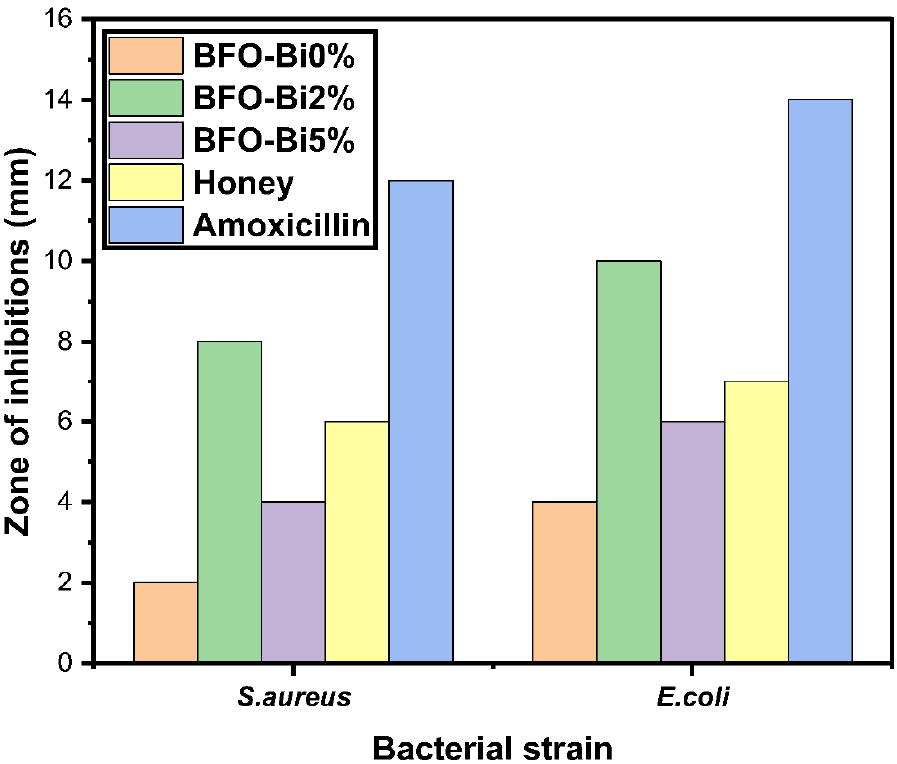
Figure 7. Antibacterial activity BiFeO 3 nanoparticles and honey solution.